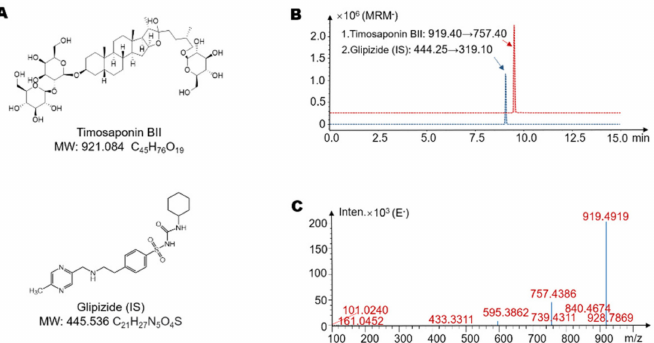
Figure 1. The structure and mass spectra of timosaponin BII. ( A ) The structural formula of timo- saponin BII and the Glipizide (internal standard (IS)). ( B ) Extracted ion chromatogram (EIC) spectra of timosaponin BII and the internal standard (Glipizide). ( C ) The high-resolution mass spectra of timosaponin BII acquired by LC/MS-Q-TOF.